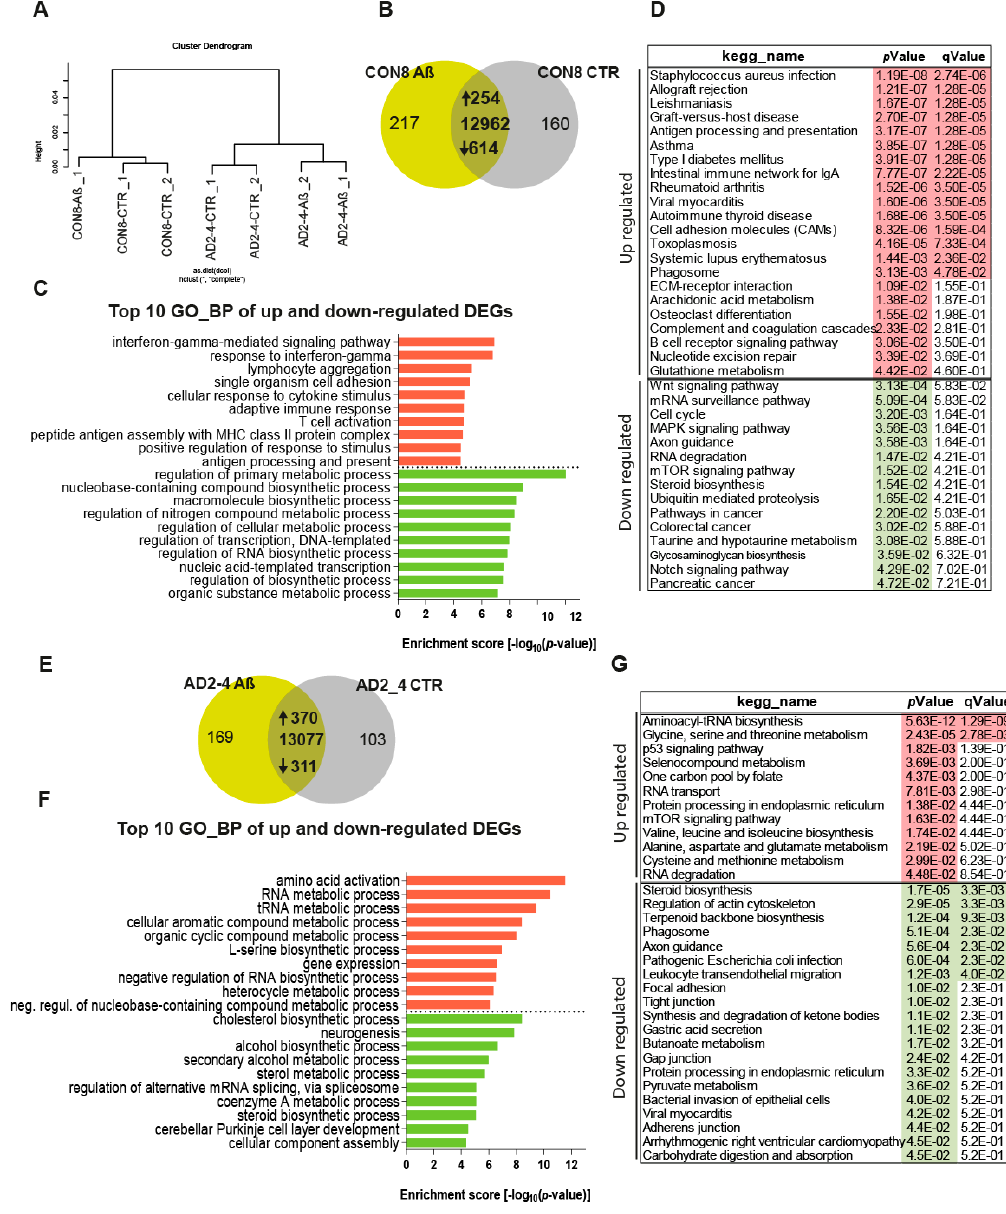
Figure 4. Gene expression profiles of the CON8 and AD neural cultures stimulated with the A β -S8C dimer. ( A ) Dendrogram obtained by hierarchical cluster analysis of microarray-based (Affymetrix) gene expression data for CON8 and AD2-4 stimulated with the A β -S8C peptide. Transcriptomes of CON8_CTR cluster with CON8_ A β while those of the AD2-4_CTR cluster separately with TREM2-4_ A β . ( B ) Venn diagram showing genes expressed only in the CON8 neural network subjected to A β -S8C peptide stimulation (green), the control condition (grey) and common to both conditions (intersection; detection p value < 0.05). ( C ) Top 10 significantly enriched gene ontology (GO) terms for biological processes of DEGs upregulated (254-red) and downregulated (614-green) subjected to A β -S8C peptide stimulation in CON8 neuronal cultures ( p -value < 0.05). ( D ) KEGG enrichment analysis of up- and downregulated DEGs ( p -value < 0.05). ( E ) Venn diagram showing genes expressed only in the AD2_4 neuronal culture when stimulated with the A β -S8C peptide (green), the control condition (grey) and common to both conditions (intersection; detection p value < 0.05). ( F ) Top 10 significantly enriched gene ontology (GO) terms for biological processes of DEGs upregulated (370-red) and downregulated (311-green) subjected to A β -S8C peptide stimulation in the AD2_4 neuronal cultures ( p -value < 0.05). ( G ) KEGG enrichment analysis of up- and downregulated DEGs ( p -value <